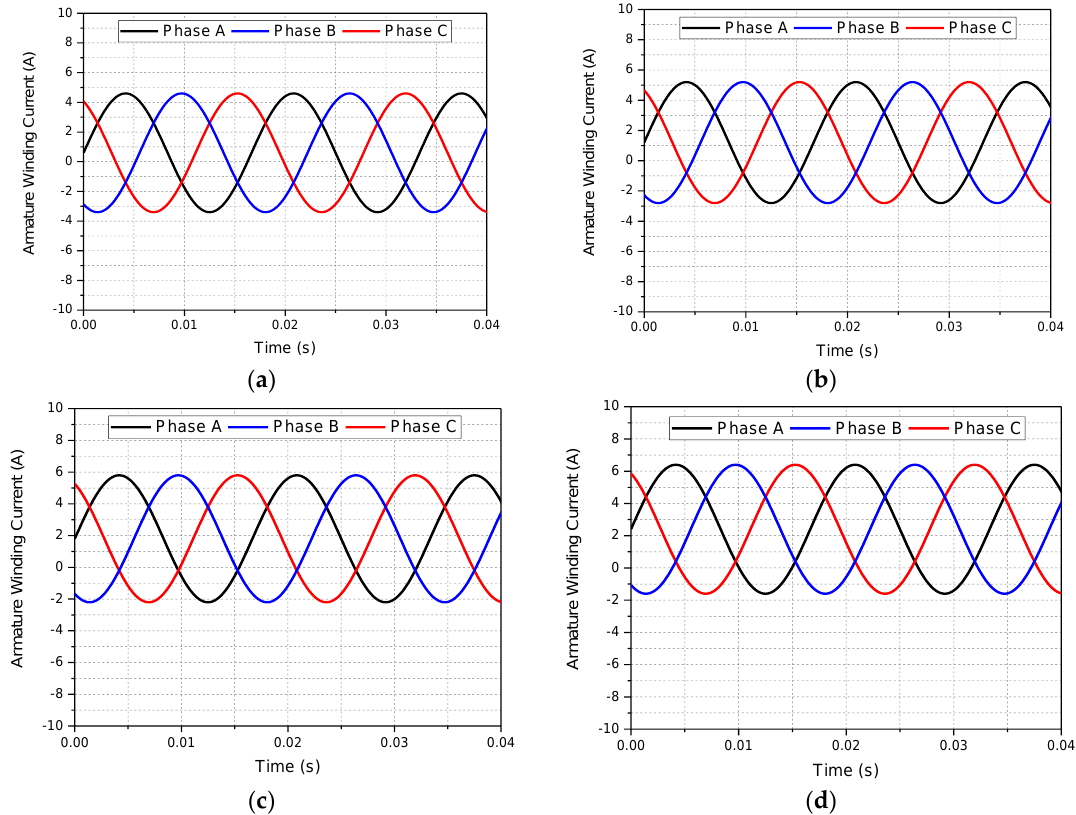
Figure 5. Armature winding currents with ( a ) 0.6 A, ( b ) 1.2 A, ( c ) 1.8 A, and ( d ) 2.4 A dc offset for each phase.